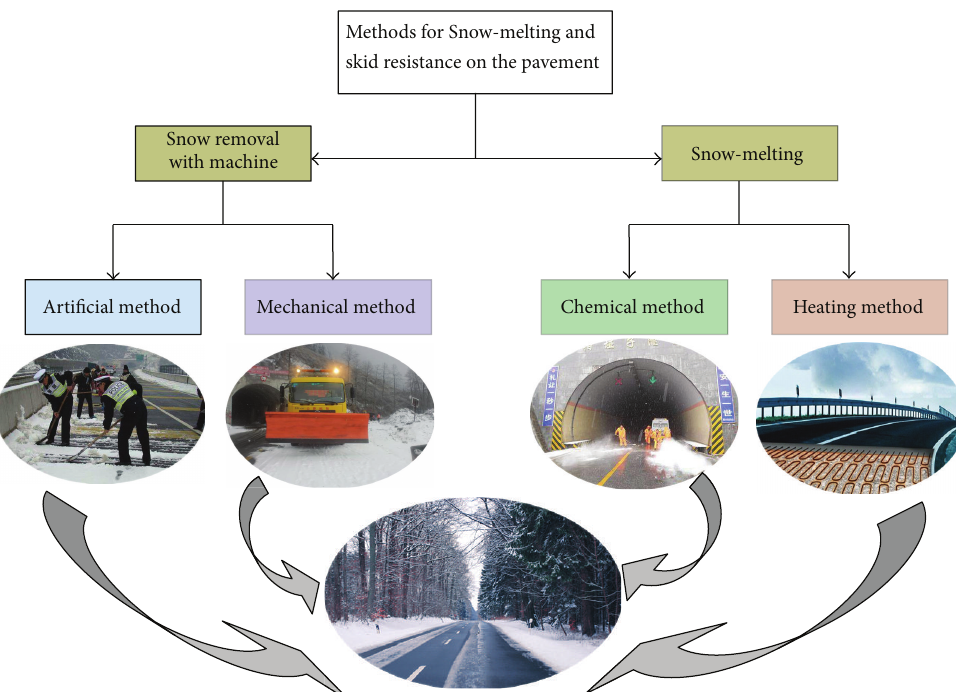
Figure 2: Methods for snow-melting and skid resistance of the